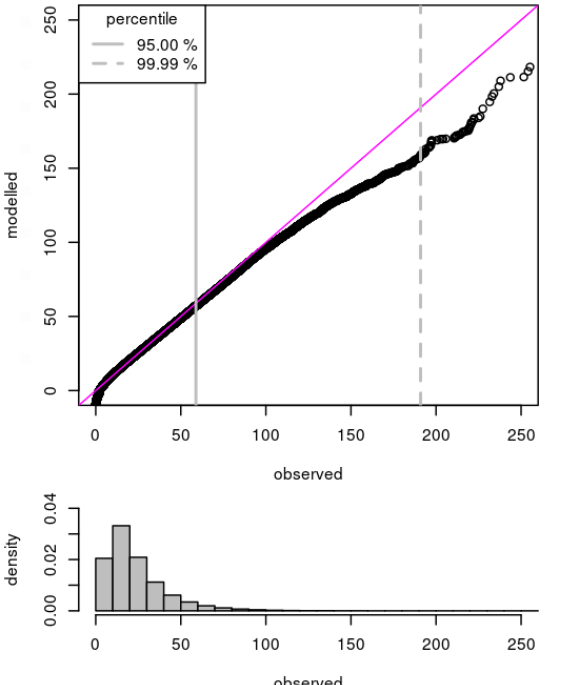
Figure 4. The Q-Q plot and histogram of the observed and modelled values of run 7 with dataset (1) with the 95 % (solid line) and 99.99 % (dashed line) percentile of measured values within the dataset (1).